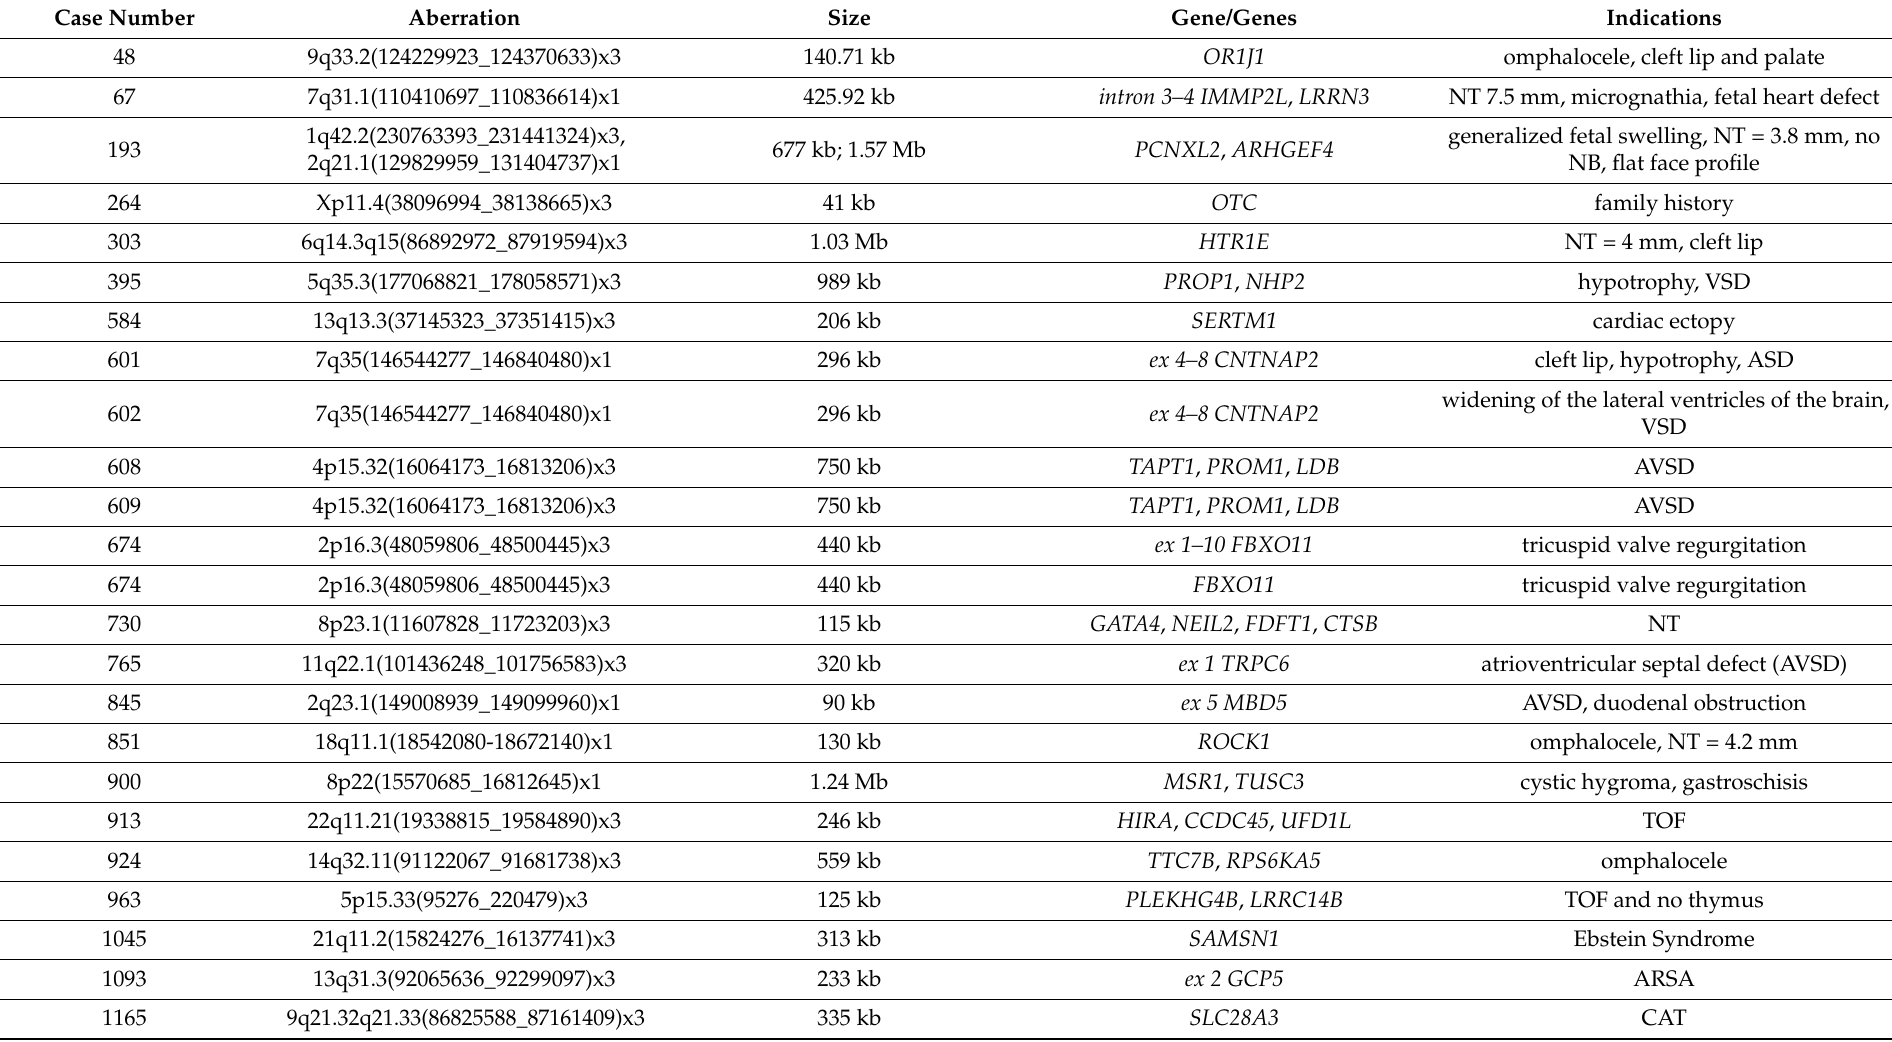
Table 8. Variants of unknown significance and the genes within CNV, which may be responsible for abnormal